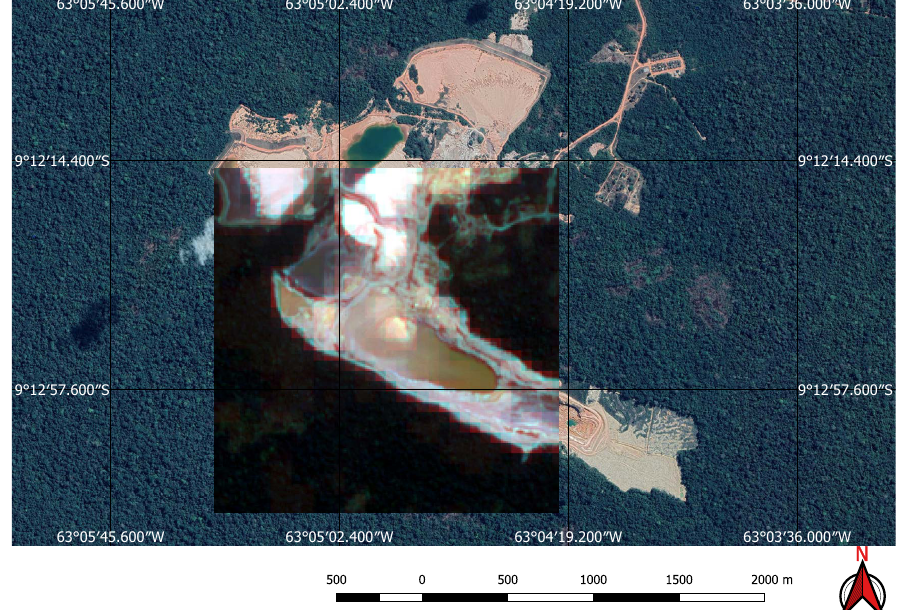
Figure 4. Sentinel 2 image of the mine and dam shown in Figure